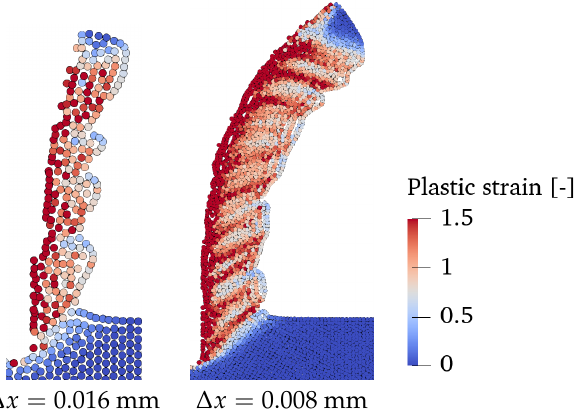
Figure 9. Effect of SPH particles size on the chip shape, where ∆ x is the diameter of SPH particles.